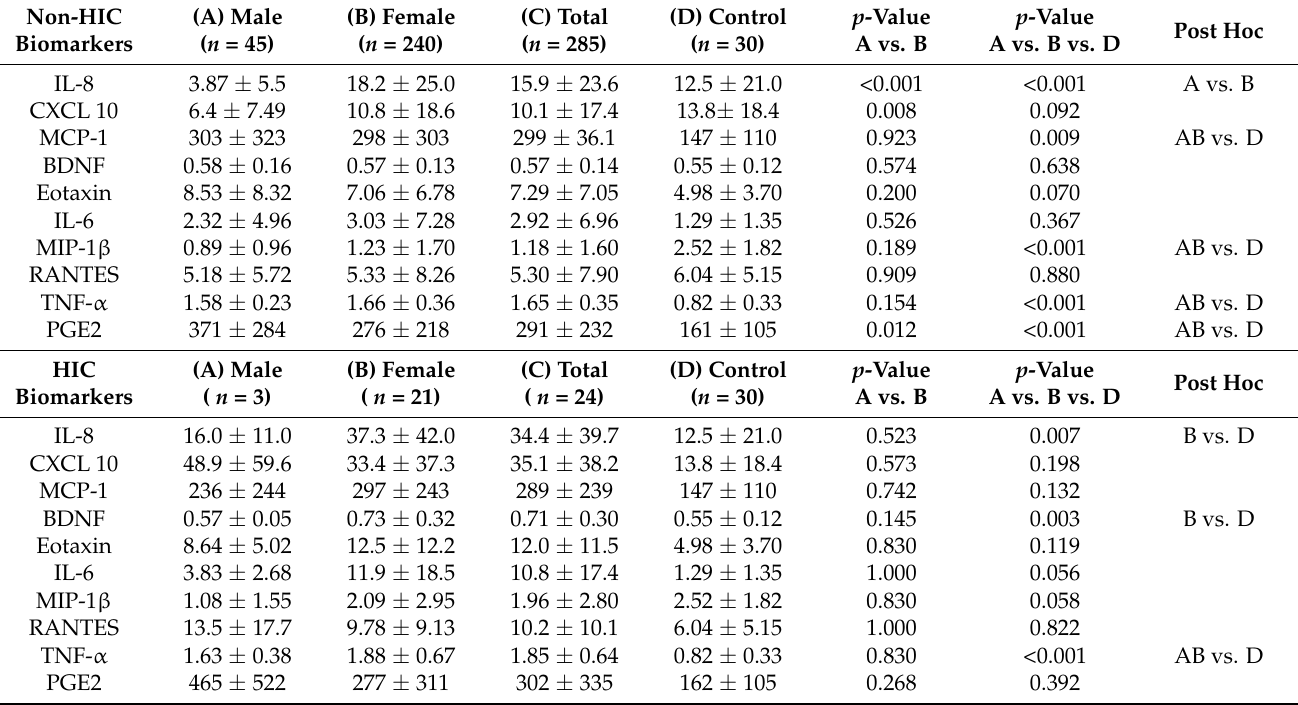
Table 2. Urinary biomarker levels between male and female patients with interstitial cystitis/bladder pain syndrome with and without Hunner’s lesion and controls.